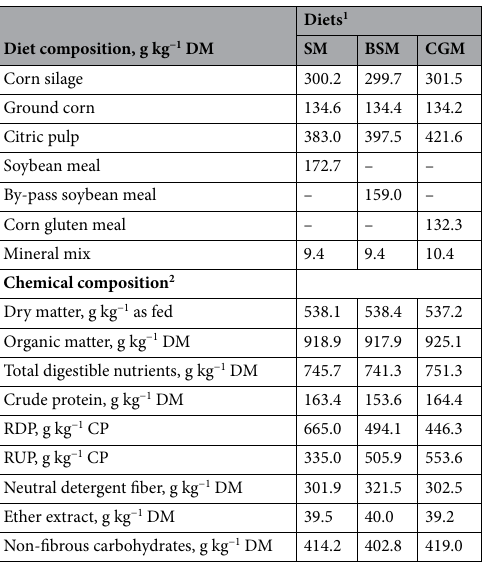
Table 7. Ingredients and chemical composition of the diets. 1 SM = manure of animals fed soybean meal as a source of rumen degradable protein (RDP), BSM = manure of animals fed by-pass soybean meal as a source of rumen undegradable protein (RUP), CGM = manure of animals fed corn gluten meal as a source of RUP; 2 DM = dry matter, CP = crude protein.